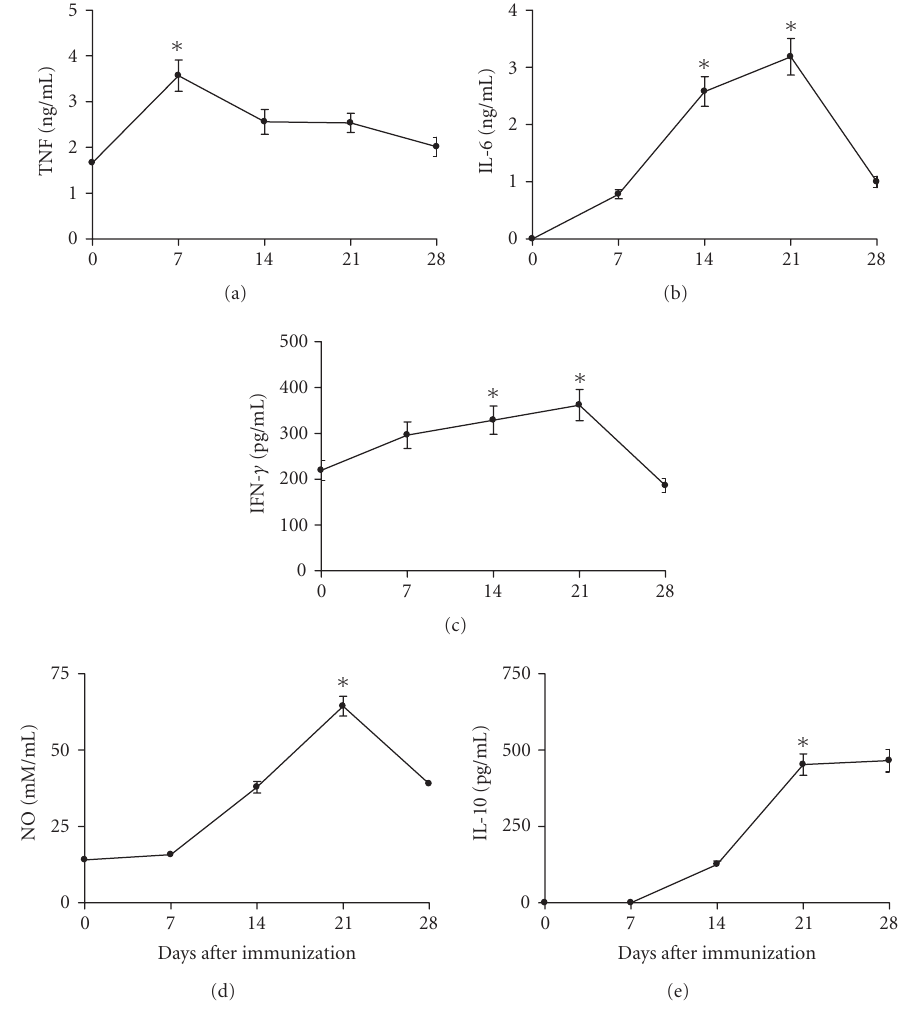
Figure 6: Kinetics of pro- and anti-inflammatory cytokines. Groups of mice were immunized subcutaneously with 0 . 5 LD 50 . Sera samples were collected on days 0, 7, 14, 21, and 28 days after immunization. The cytokines levels were determined as described in “Materials and Methods.” The experiment was repeated twice and each point represents the values of pooled sera from 5 animals between the treatments were marked with asterisk ( P < . 001 for IL-6, IL-10, IFN- γ , and NO) and ( P < . 01 for